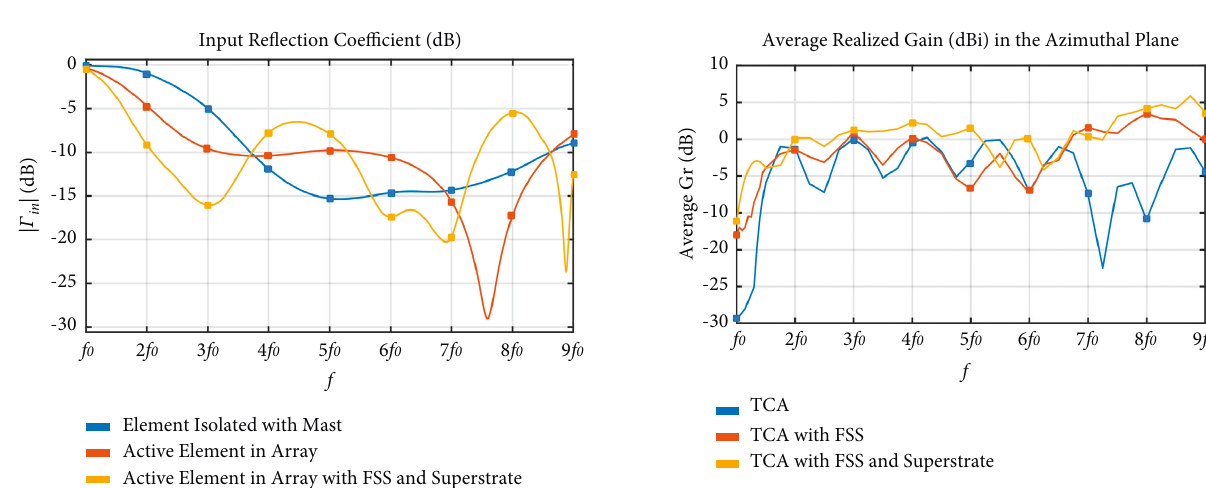
Figure 8: Main array configurations compared in terms of simulated performances.